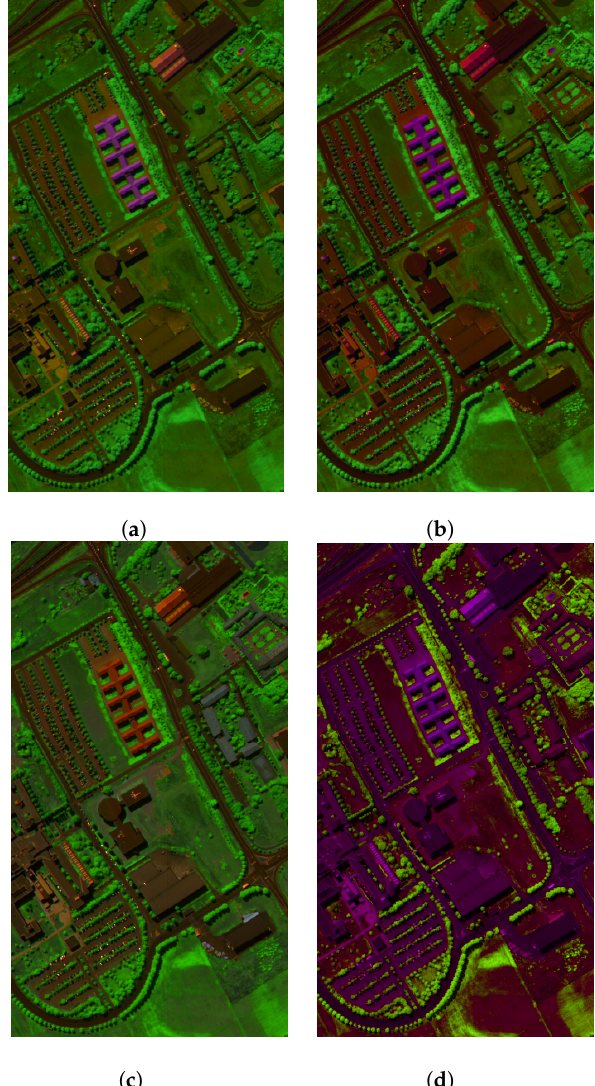
Figure 12. RGB false color visualization of first three eigenimages from Pavia hyperspectral image: ( a ) classical PCA on spectral bands; ( b ) scale-decomposition MorphPCA; ( c ) pattern spectrum MorphPCA; ( d ) distance function